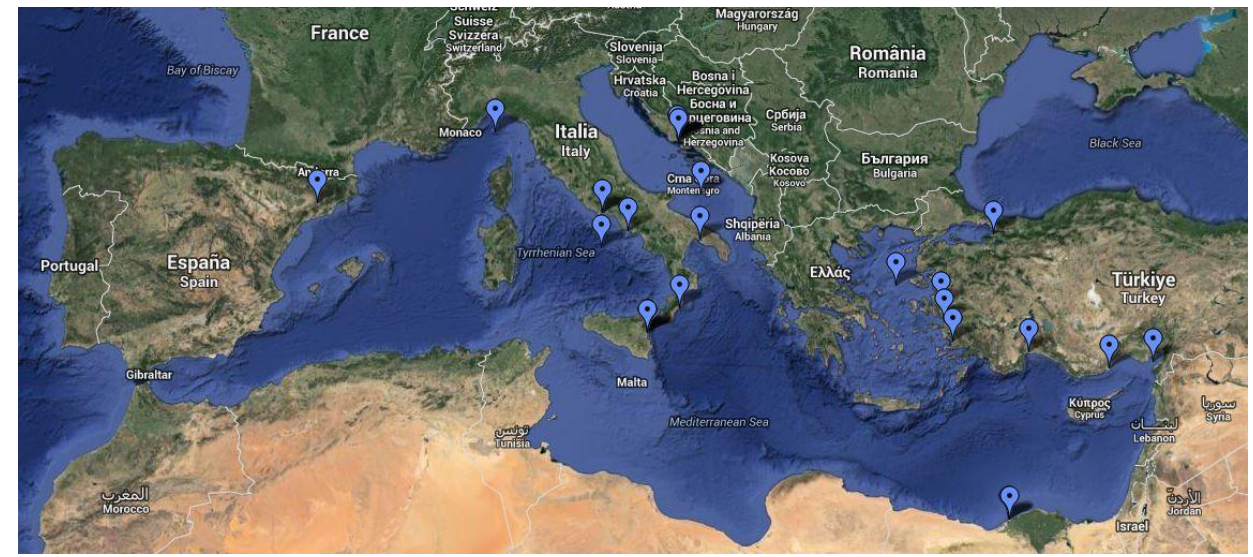
Figure 1. Sampling